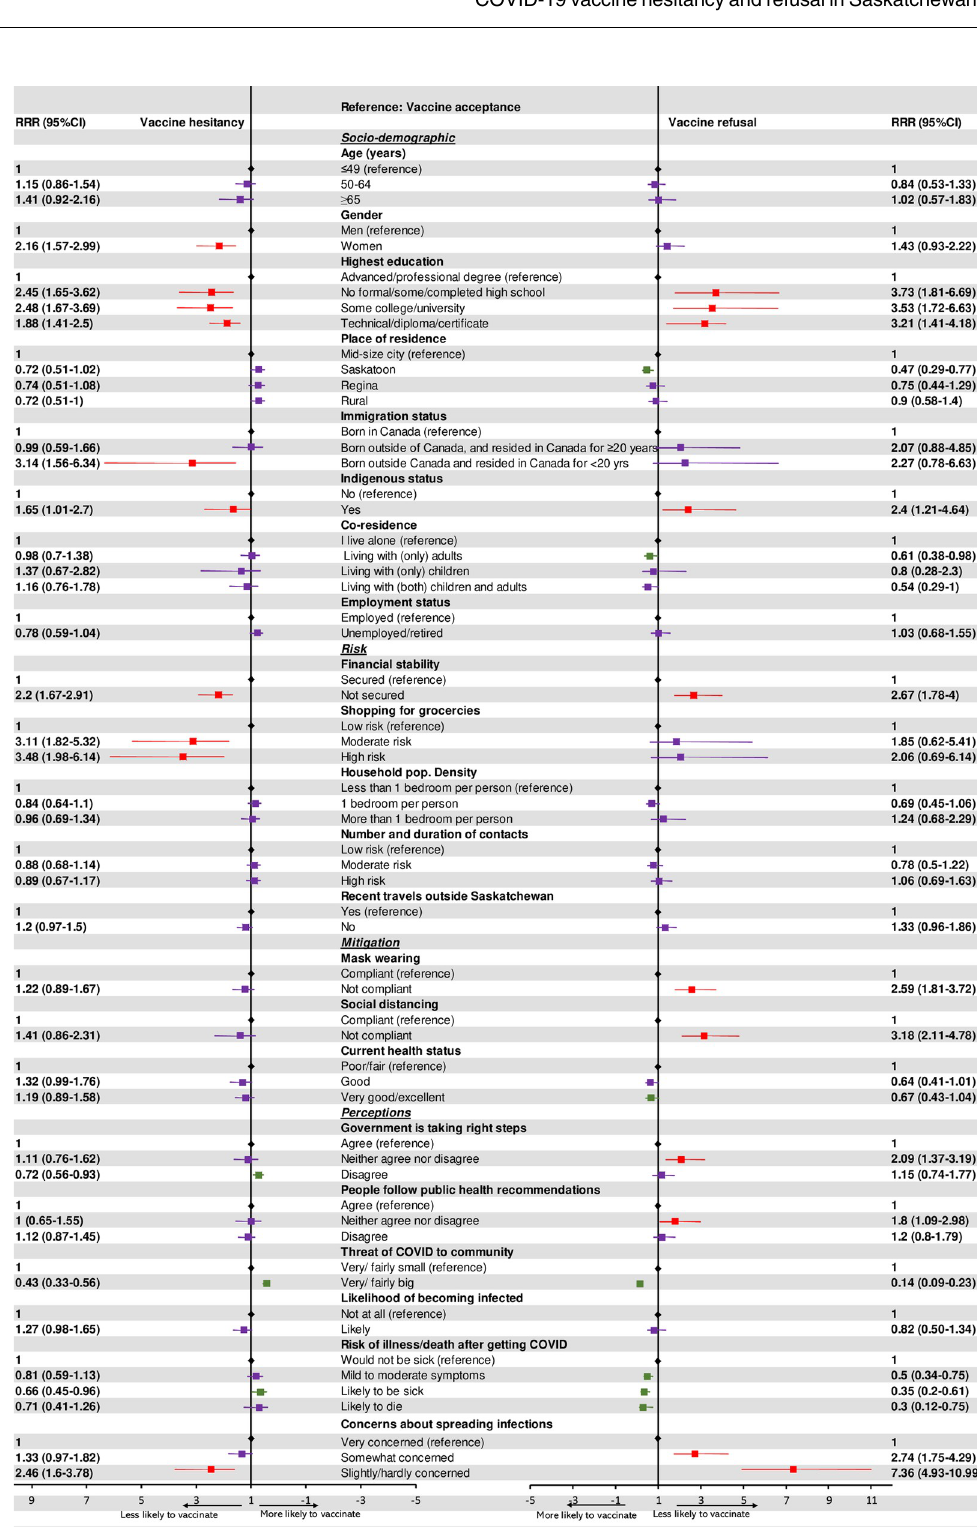
Fig 1. Adjusted relative risk ratios for the determinants of COVID-19 vaccine intent in Saskatchewan, Canada. Color code: black (reference), green (likely to be vaccine ready), red (likely to refuse or hesitant), and purple (not statistically